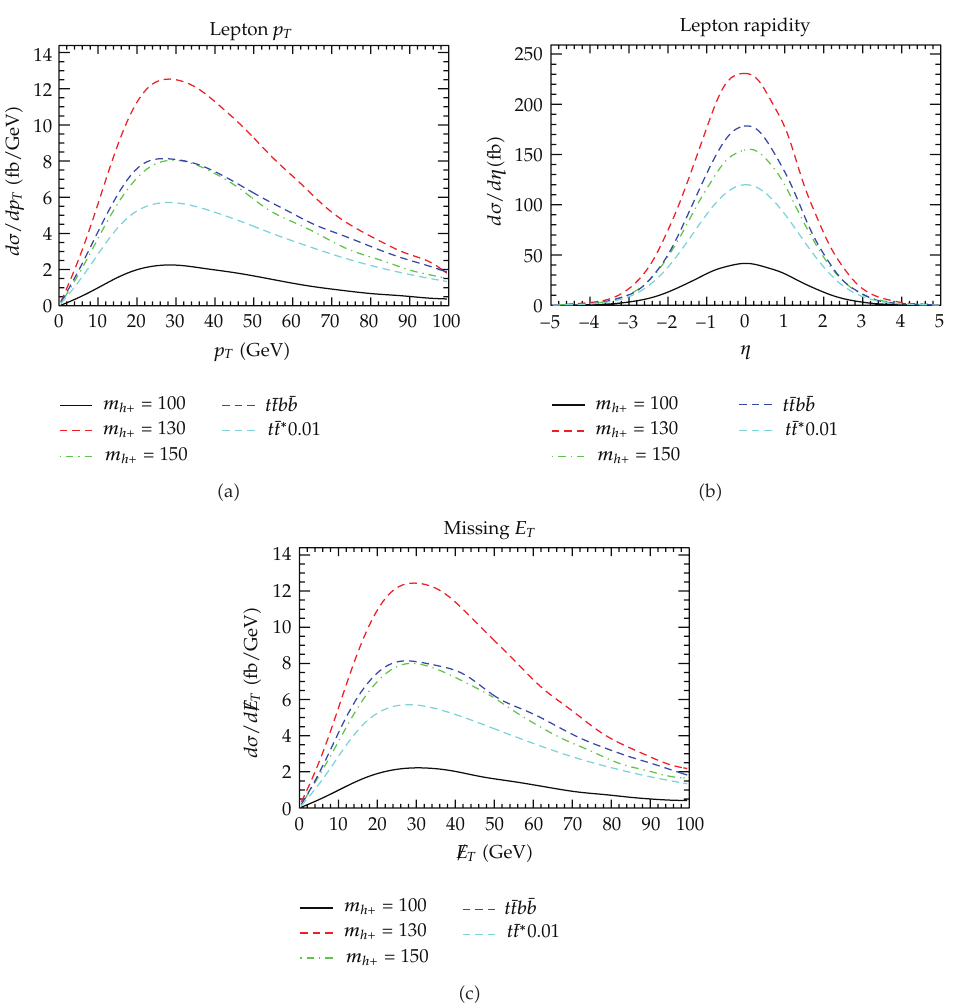
Figure 5: Transverse momentum and pseudorapidity of the charged lepton from the W decay and missing transverse energy (cid:2) MET (cid:3) before applying